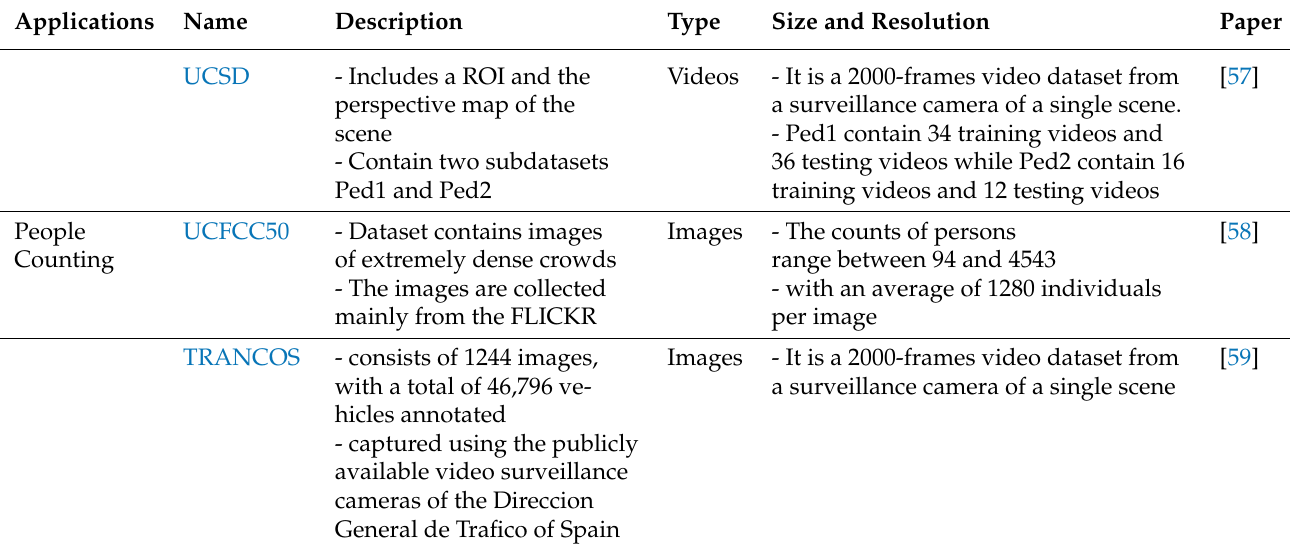
Table 4. Frequently used